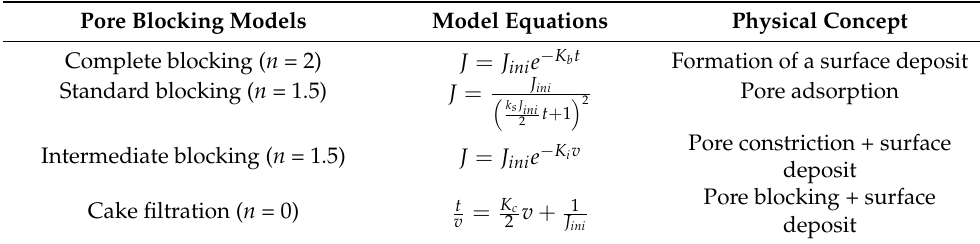
Table 3. Four ratiocinative models of Hermia blocking